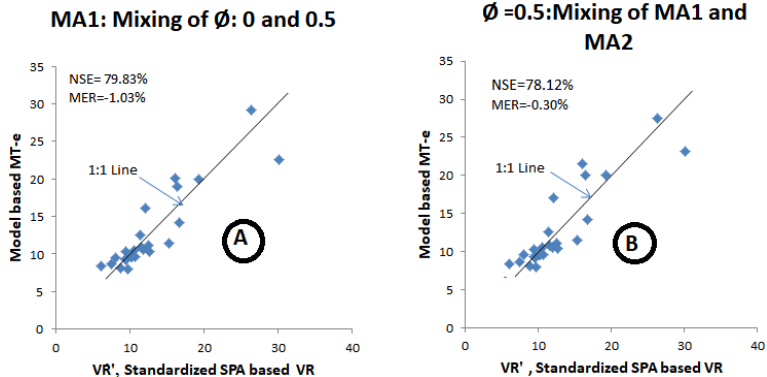
Figure 2. Comparison of M T-e to SPA-based standardized reservoir volume with cutoff = SHI o : ( A ) and ( B ) respectively, represent Combination-A and Combination-B.